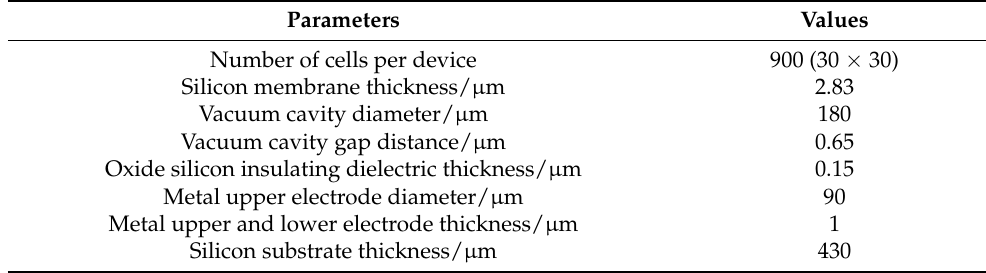
Table 2. Structure parameters of CMUT.